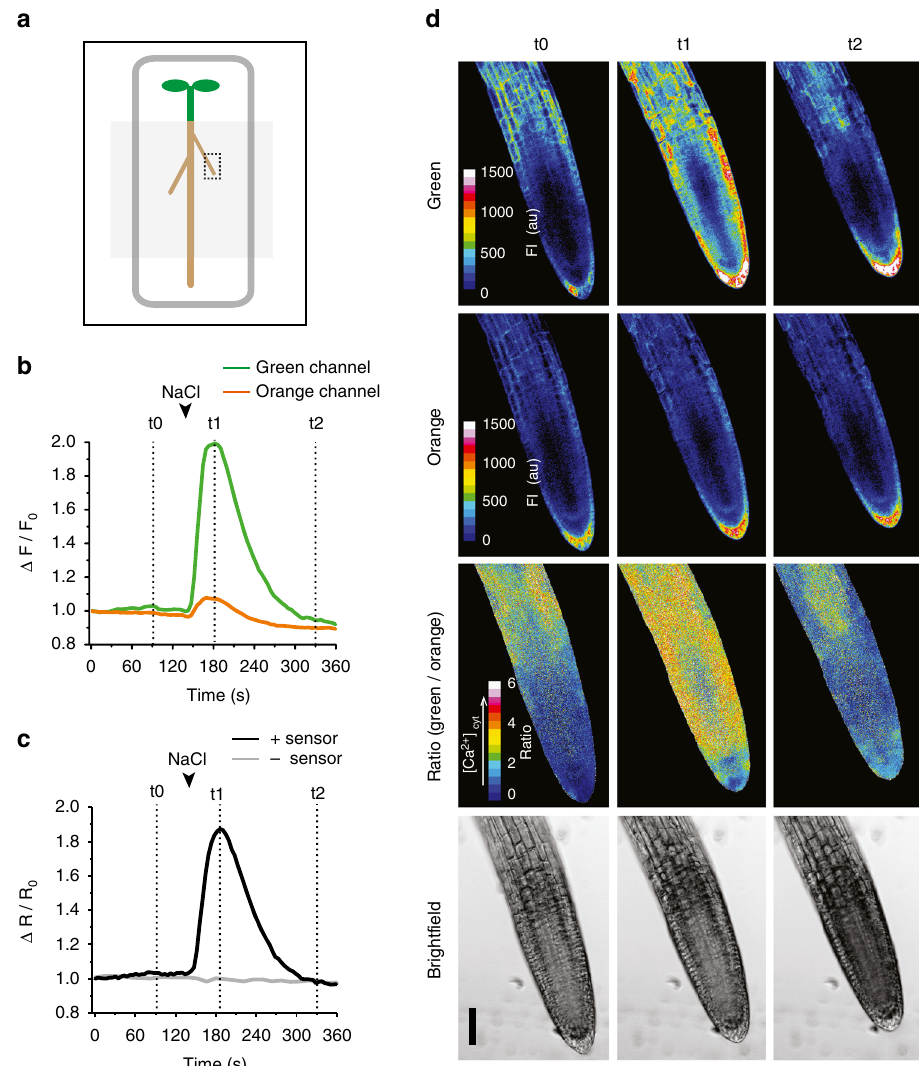
Fig. 3 Arabidopsis seedlings expressing MatryoshCaMP6s report root cytosolic calcium elevation in response to salt shock. a Cartoon diagram of Arabidopsis seedling mounted on large cover slip. Media- fi lled reservoir was made by applying vacuum grease ( dark gray ) and a smaller cover slip ( light gray box ). Imaged region is indicated by the dotted box. b , c Sensor response, from a single seedling treatment, recorded across the entire fi eld of view. Arrowheads mark the time (147 s) that roots were exposed to salt shock by addition of NaCl to the growth media. Final concentration in reservoir after treatment was estimated to be 50 mM. Time points (t0 – t2) indicate representative images included in fi gure panel. Graphs display the normalized mean FI values for green and orange channels ( b ) and the normalized ratio of green to orange mean FI values ( c , black line ), extracted after applying a binary mask made from the orange channel to the ratiometric data. A background control seedling without the sensor ( gray line ), was used as an auto fl uorescence control and no ratio change was observed with treatment. d Average z-stack projections of confocal images showing Arabidopsis lateral root before NaCl treatment (t0, 100 s), during peak response (t1, 186 s), and after signal intensities returned to baseline conditions (t2, 334 s). Sample was co-illuminated with 440 and 488 nm lasers. Emission intensities were simultaneously collected at 500 – 540 nm (Green Channel; fi rst row ) and 570 – 650 nm (Orange Channel; second row ) and are shown in 16-color lookup table with FI indicated in arbitrary units. The ratio of green to orange FI is shown by 16-color lookup table (Green/Orange, third row). Bright fi eld images for each time point are shown (single slice, bottom row). Scale bar indicates 50 μ m. At least three biological replicates were analyzed (see Supplementary Fig. 7 for additional data). All images are supported by videos (Supplementary Movies 1 – recording of LSSmOrange emission, providing us with the advantage for discriminating transfected cells from non- transfected cells, since GCaMP6s is dim at resting state. Also, the LSSmOrange served as stable control throughout the MeCh treatment (Fig. 4b). Photobleaching experiments of HEK293T cells expressing GCaMP6s or MatryoshCaMP6s revealed similar half-life ( τ 1/2 ) values for MatryoshCaMP6s ( τ 1/2 = 25.5 ± 2.8 s; mean ± s.e.m. n = 5) compared to the parent sensors GCaMP6s ( τ 1/2 = 22.8 ±